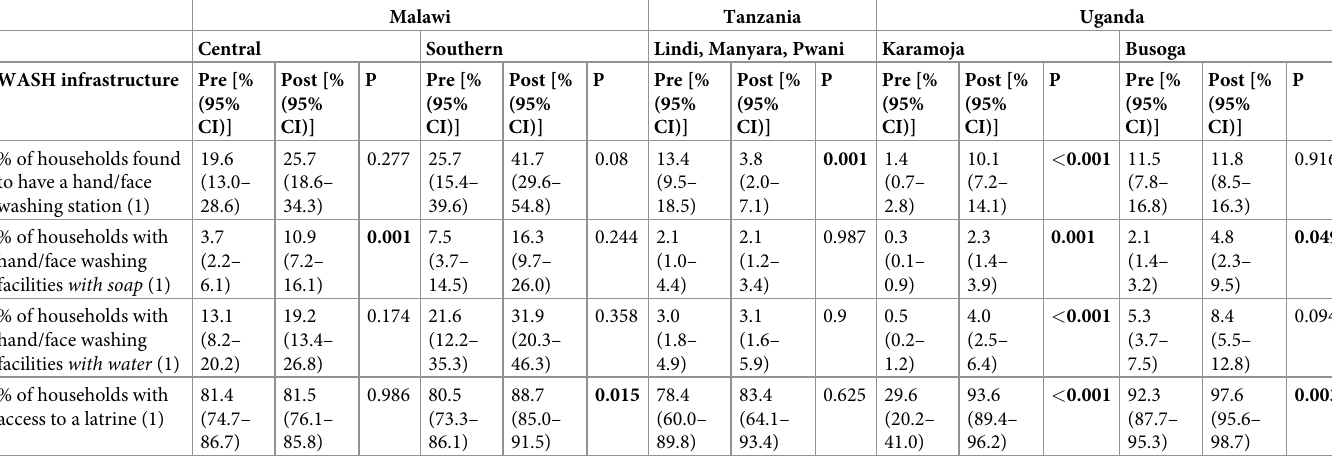
Table 5. WASH infrastructure survey results by community evaluation unit at pre and post-surveys. Malawi Tanzania Uganda